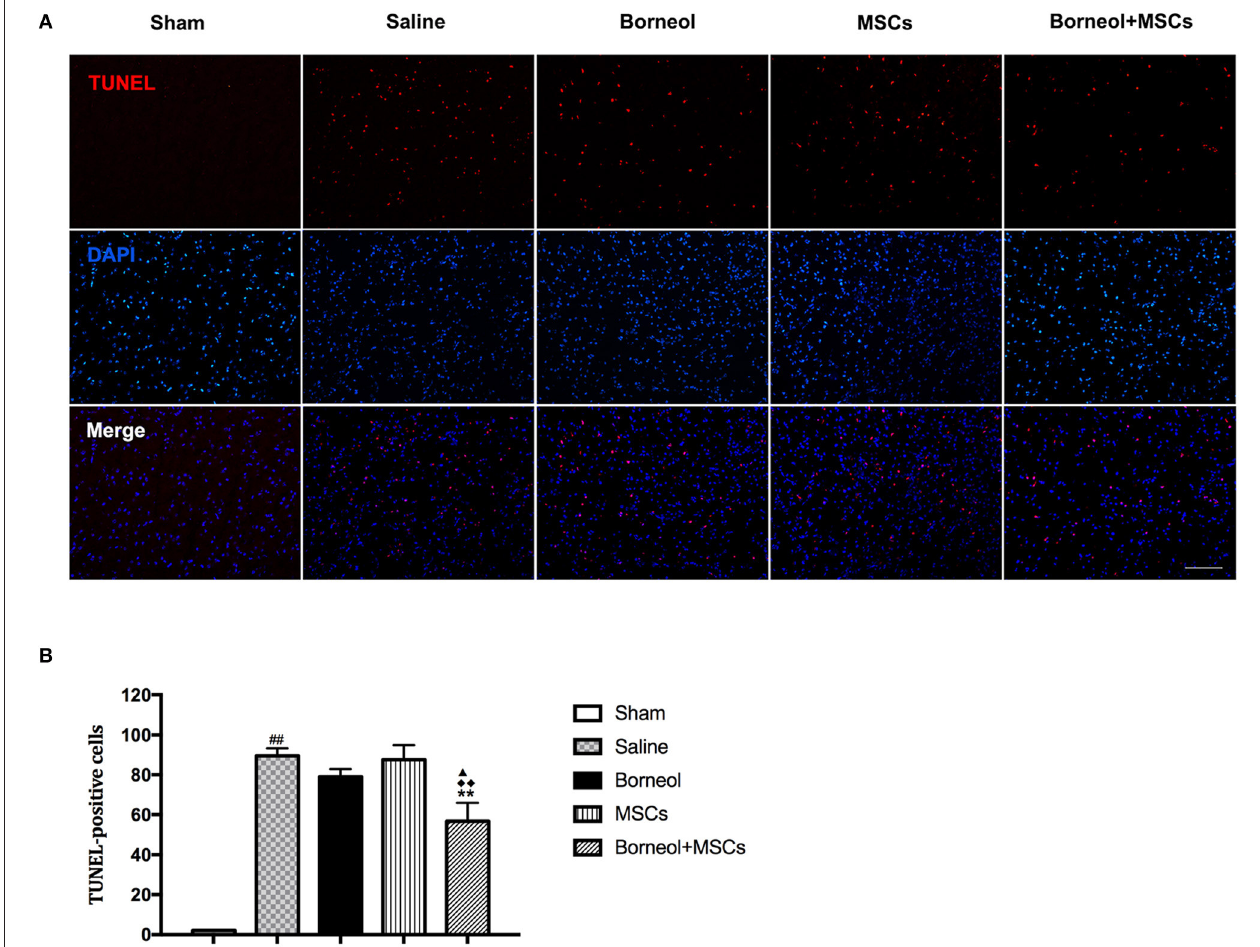
FIGURE 5 | Effect of borneol and MSCs transplantation on cell death at 7 d after MSCs transplantation. (A) Photomicrographs (*200) of apoptotic cells. (B) Quantitative analysis of the number of TUNEL positive cells. Data were expressed as mean ± SD . ## P < 0.01 compared with sham group; ** P < 0.01 compared with MCAO plus saline group; N P < 0.05 compared with borneol group; (cid:7)(cid:7) P < 0.01 compared with MSCs